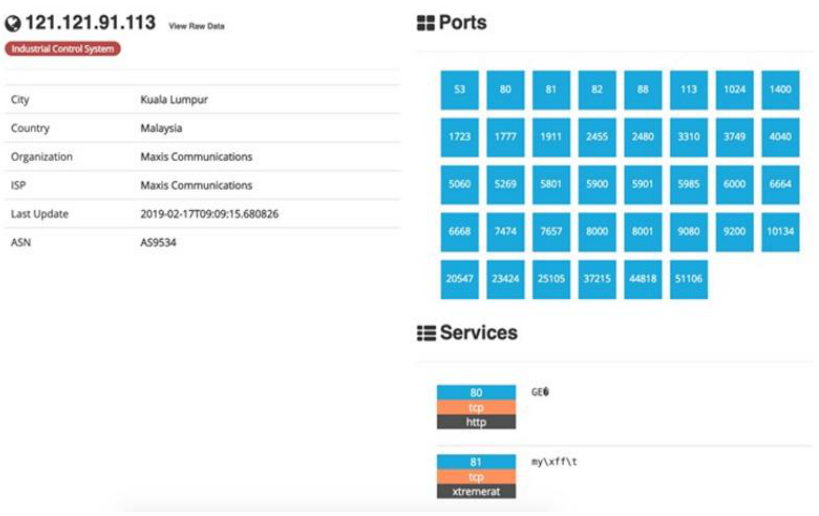
Figure 2. A sample of Shodan search outcome .